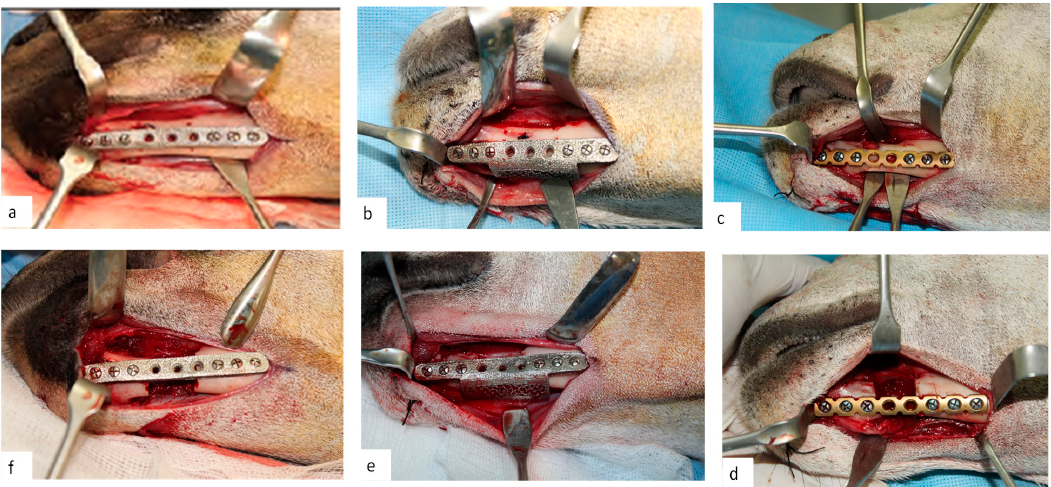
Figure 8. Three di ff erent reconstruction plates fixed with screws ( d – f ) on the previous marked segmental Figure 8. Three different reconstruction plates fixed with screws ( d – f ) on the previous marked defect margins and screw holes ( a – c segmental defect margins and screw holes ( a – c ).